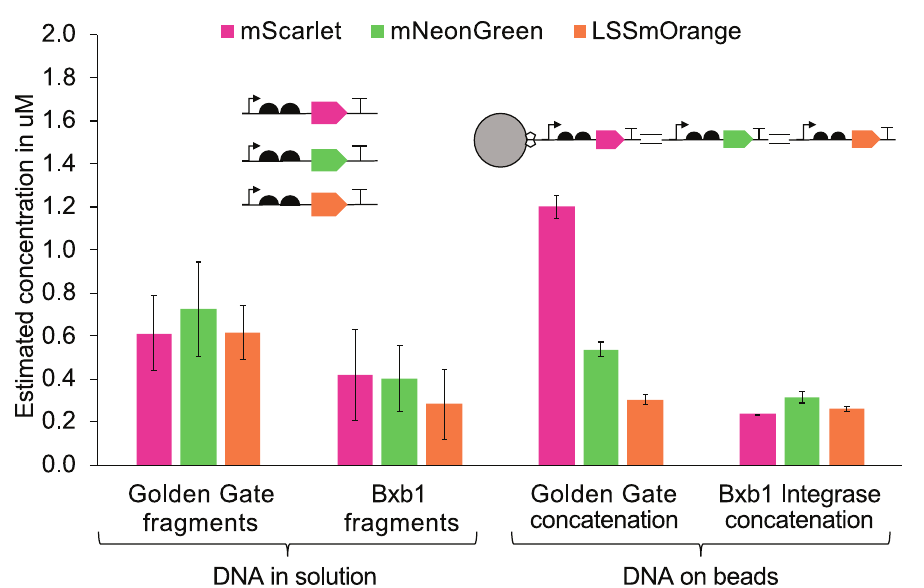
Fig 2. Co-expression of three proteins in bulk reactions (25 μ l) from linear DNA templates supplied in solution (control) or from DNA immobilized on micro-beads. Equal quantities of PCR fragments encoding red, green and orange fluorescent proteins were either directly mixed into PureExpress reactions (controls, left) or were sequentially immobilized on beads using two different solid-phase gene coupling strategies (Golden Gate and Bxb1 Integrase concatenation). Expression was measured by fluorescence and calibrated against purified fluorescent proteins. Error bars indicate the standard deviation among